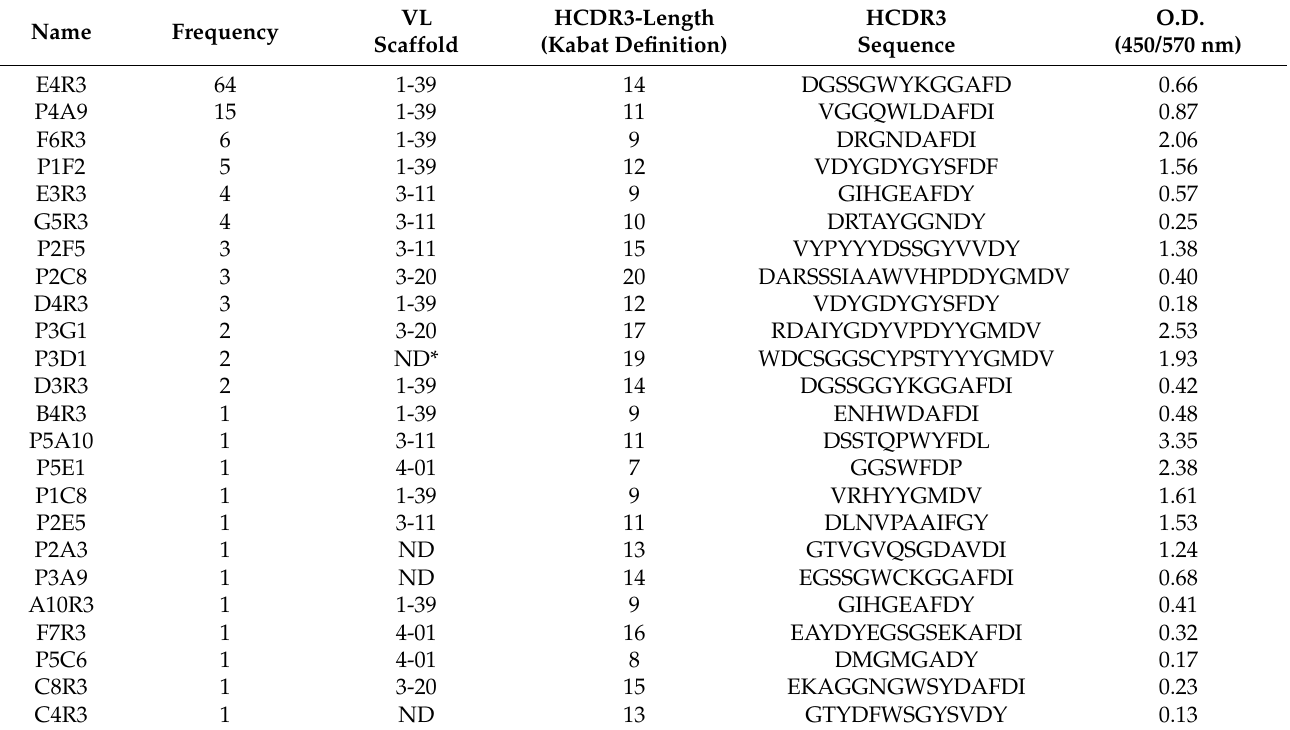
Table 1. ALTHEA Gold Plus Libraries™ selection outcome after three rounds of panning with RBD